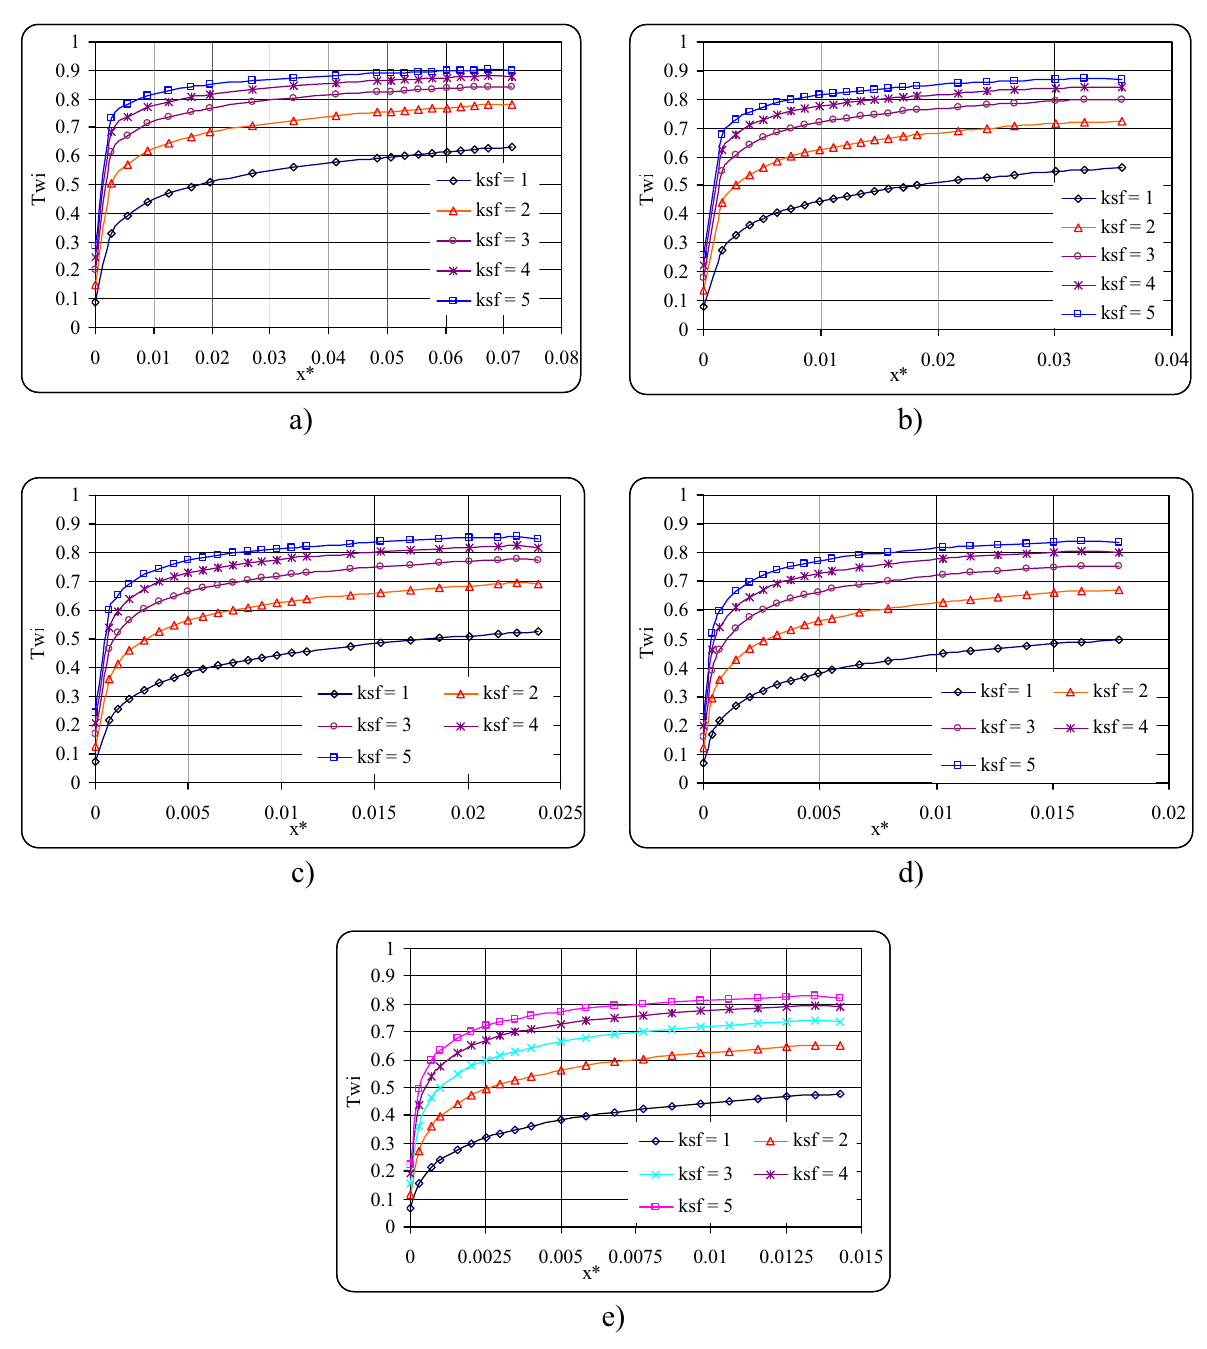
Figure 4: Relationship between dimensionless inside wall temperature vs dimensionless axial coordinate δ /R i = 0.5 and Pr = 7, with variable ksf ratio. ( a ) Re = 200, ( b ) Re = 400, ( c ) Re = 600, ( d ) Re = 800, and ( e ) Re =